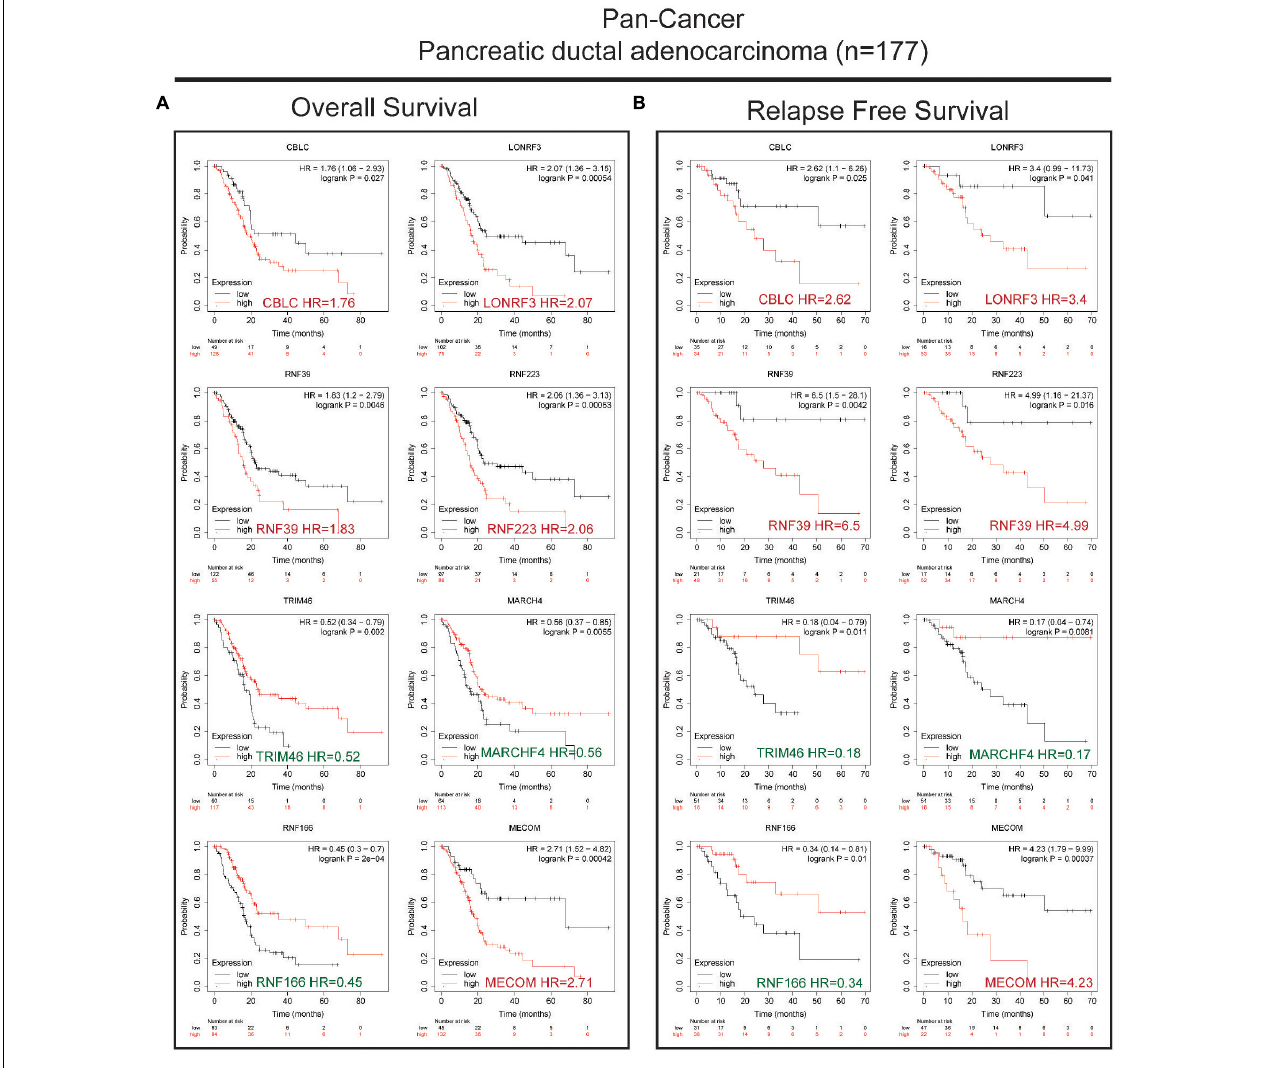
FIGURE 3 | Validation of the OS and RFS rates using the PAAD dataset in a pan-cancer study. (A) Kaplan–Meier survival analysis showing the HR of eight genes’ expression with OS rate in the pan-cancer PAAD dataset. (B) Kaplan–Meier survival analysis showing the HR of eight genes’ expression with RFS rate in the pan-cancer PAAD dataset. Favorable and unfavorable markers were labeled in green and red, respectively.